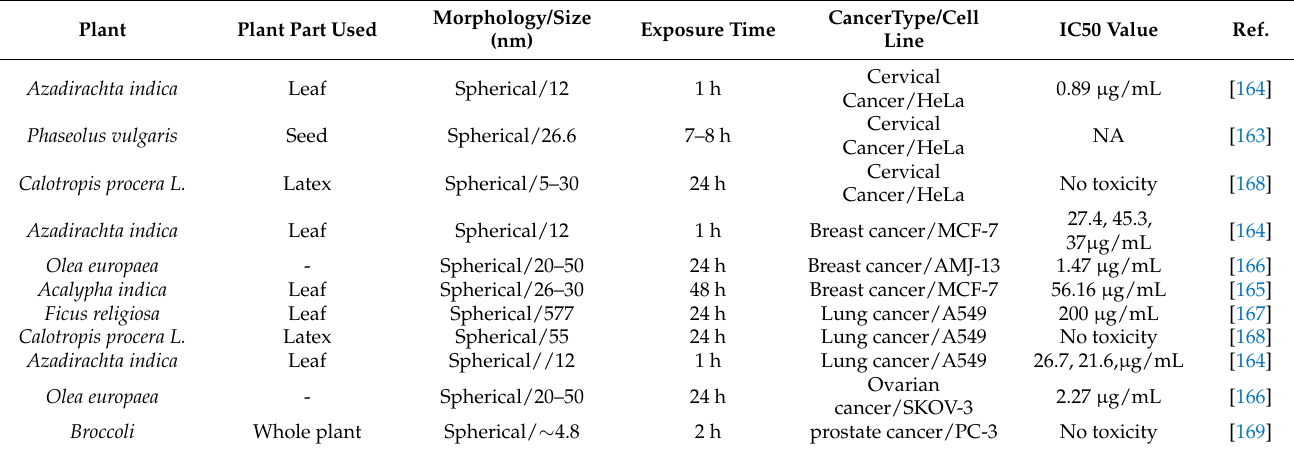
Table 4. List of studies exhibiting biosynthesized copper/copper oxide NPs and their anticancer activity. Plant Plant Part Used